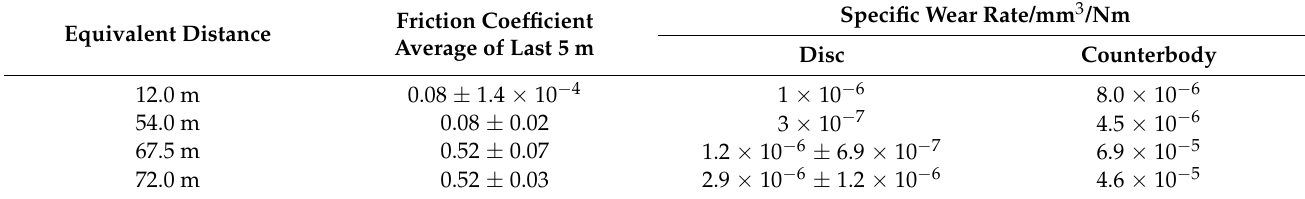
Table 3. COF and specific wear rate results from the three long-term experiments of brass/ta-C under high vacuum. In two out of the three experiments, the friction coefficient and wear behavior worsened significantly in the long term. Results for 12.0 m sliding distance are shown for comparison. No wear on the disc of the 12.0 m and 54.0 m brass/ta-C experiments was found; therefore, the minimum measurable wear is reported.